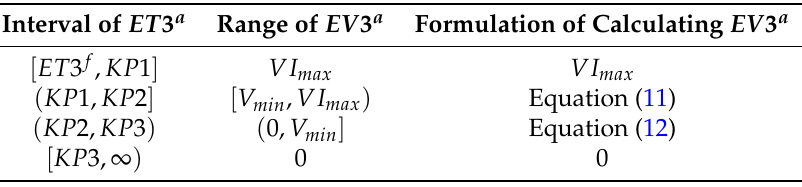
Figure 3. Calculation of the maximal EV 3 based on the ET 3 a . Table 3. Calculation of the maximal EV 3 based on the ET 3 a